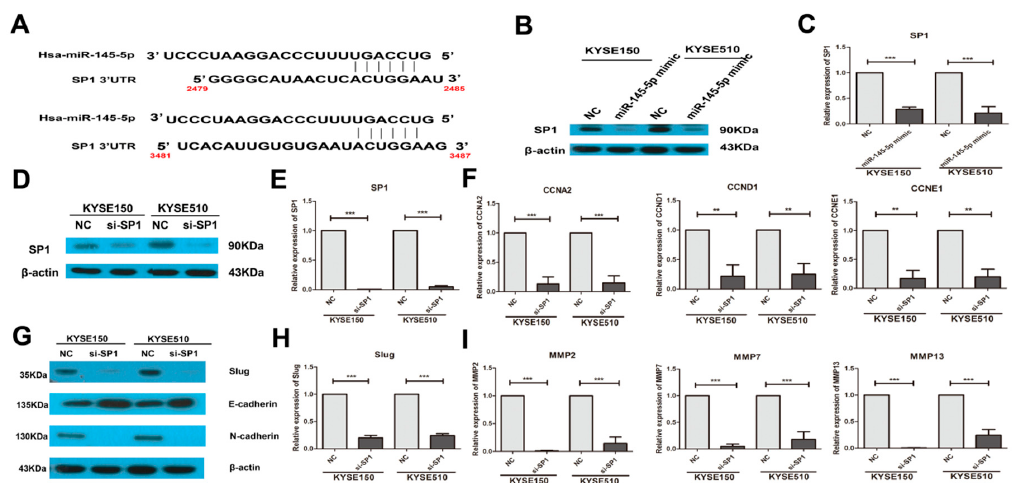
Figure 4. Overexpression of miR-145-5p down-regulated the candidate target gene Sp1 , and knockdown of Sp1 phenocopied the effects of miR-145-5p overexpression on cell cycle regulators and EMT. ( A ) The predicted sites of miR-145-5p binding to the 3 ′ untranslated (3 ′ -UTR) region of Sp1 were detected using bioinformatics prediction tools; ( B , C ) KYSE150 and KYSE510 cells were transfected with miR-145-5p mimics or a non-specific negative control for 48 h. The protein and mRNA levels of Sp1 were measured by Western blotting and real-time PCR assay, respectively ( n = 3); ( D , E ) KYSE150 and KYSE510 cells were transfected with Sp1 siRNA and a non-specific negative control for 48 h. The protein and mRNA levels of Sp1 were determined by Western blotting and real-time PCR assay, respectively ( n = 3); ( F ) The mRNA levels of CCNA2 , CCND1 and CCNE1 were determined by real-time PCR assay ( n = 3); ( G ) The protein expressions of Slug, E-cadherin and N-cadherin were measured by Western blotting assay (n=3); ( H ) The mRNA levels of Slug were determined by real-time PCR ( n = 3); ( I ) The mRNA expressions of MMP2 , MMP7 and MMP13 were determined by real-time PCR ( n = 3). NC: non-specific negative control. Three independent experiments were performed. ** p < 0.01; *** p < 0.001.